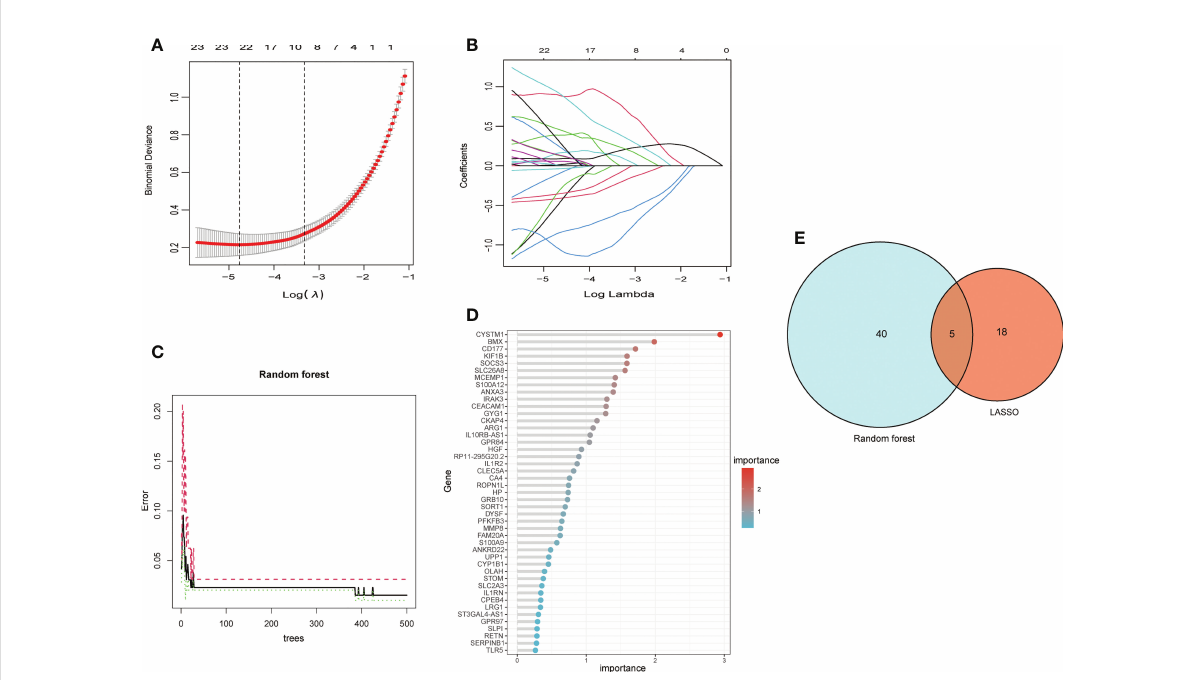
FIGURE 5 The machine algorithms for signature genes. (A) Penalty plot of the LASSO model with error bars denoting standard errors. (B) LASSO plot showed the variations in the size of coef fi cients for parameters shrank as the value of k penalty increased. (C) The error rate con fi dence intervals